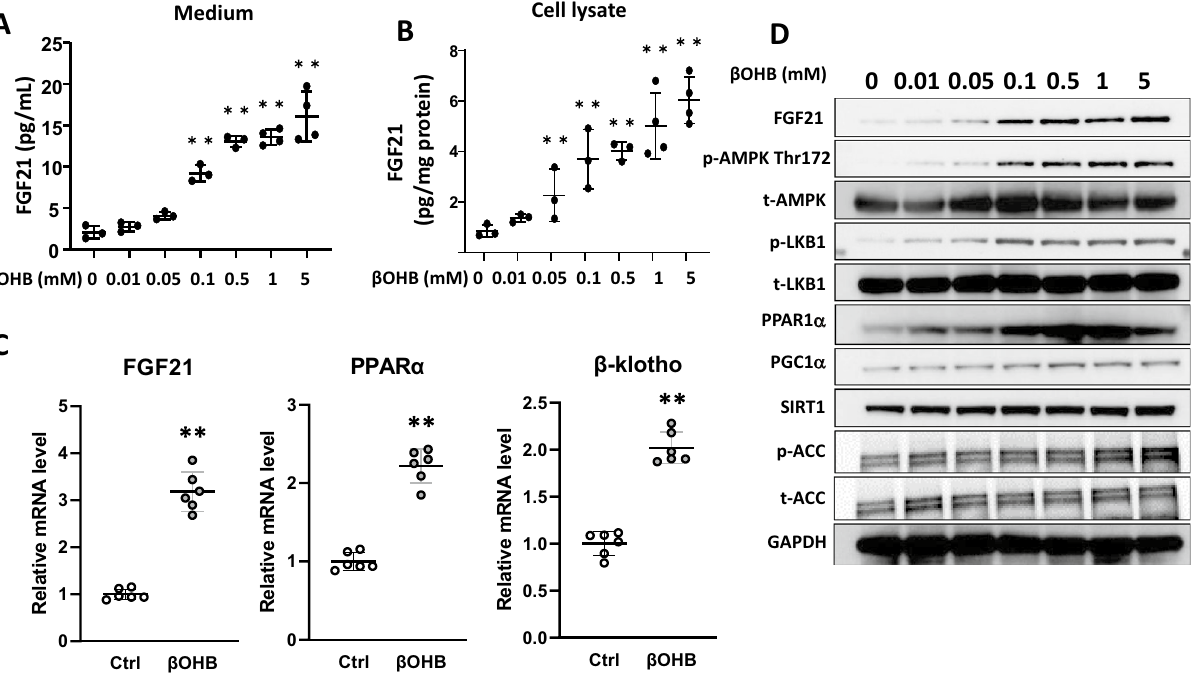
Figure 1. Effects of βOHB on FGF21 expression and signaling in cultured neonatal rat cardiac myocytes. FGF21 concentrations in cultured medium ( A ) and in cell lysates ( B ) were measured by ELISA after stimulation of cultured neonatal rat cardiac myocytes with βOHB (0–5 mM) for 24 h Data are mean ± SD (n = 3–4). **p < 0.01 vs control (0 mM) analyzed by one-way ANOVA followed by Dunnett correction for multiple comparisons. ( C ) mRNA levels for FGF21, PPARα and β-klotho were compared between the vehicle (ctrl) and βOHB (0.5 mM)-treated cardiac myocytes (n = 6). Data are mean ± SD (n = 6). **p < 0.01 vs control analyzed by unpaired Student’s t-test. ( D ) Representative western blots to assess the relative changes of FGF21 and indicated signaling molecules in response to βOHB at indicated concentrations for 24 h. Full-length blots are presented in Supplementary Fig.